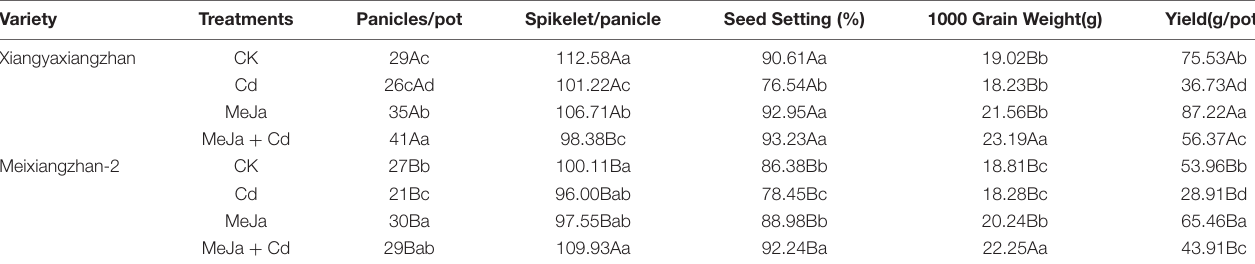
TABLE 2 | The effects of exogenous MeJa application on yield and related components in two fragrant rice cultivars under Cd stress.